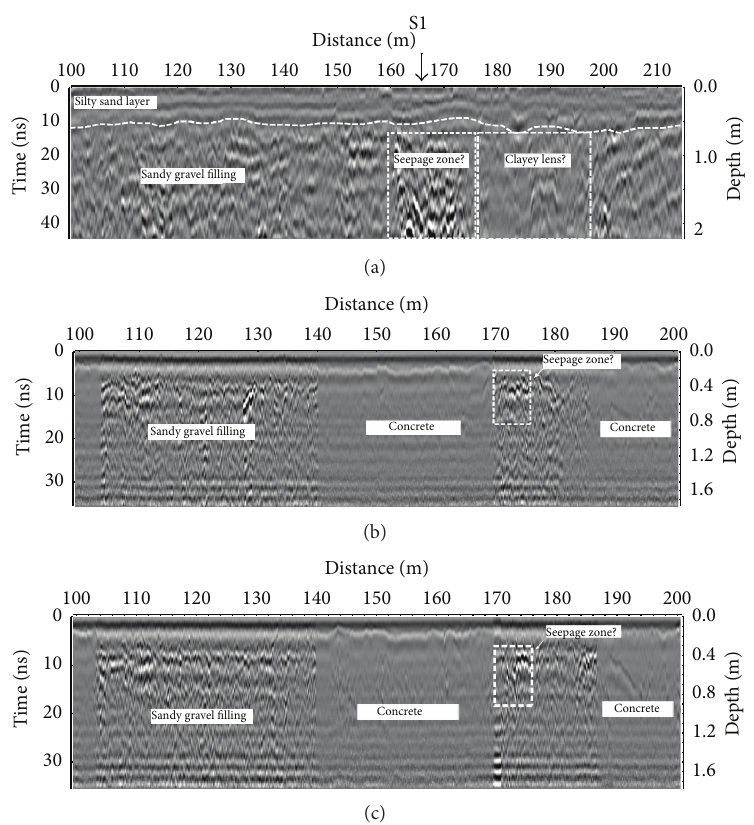
Figure 13: GPR signal associated with the second leakage zone. (a) GPR profile P6 on the crest (200 MHz); (b) GPR profile P5 on the paved revetment at 2.15 m high (400MHz); (c) GPR profile P4 of the paved revetment at 1.7m high